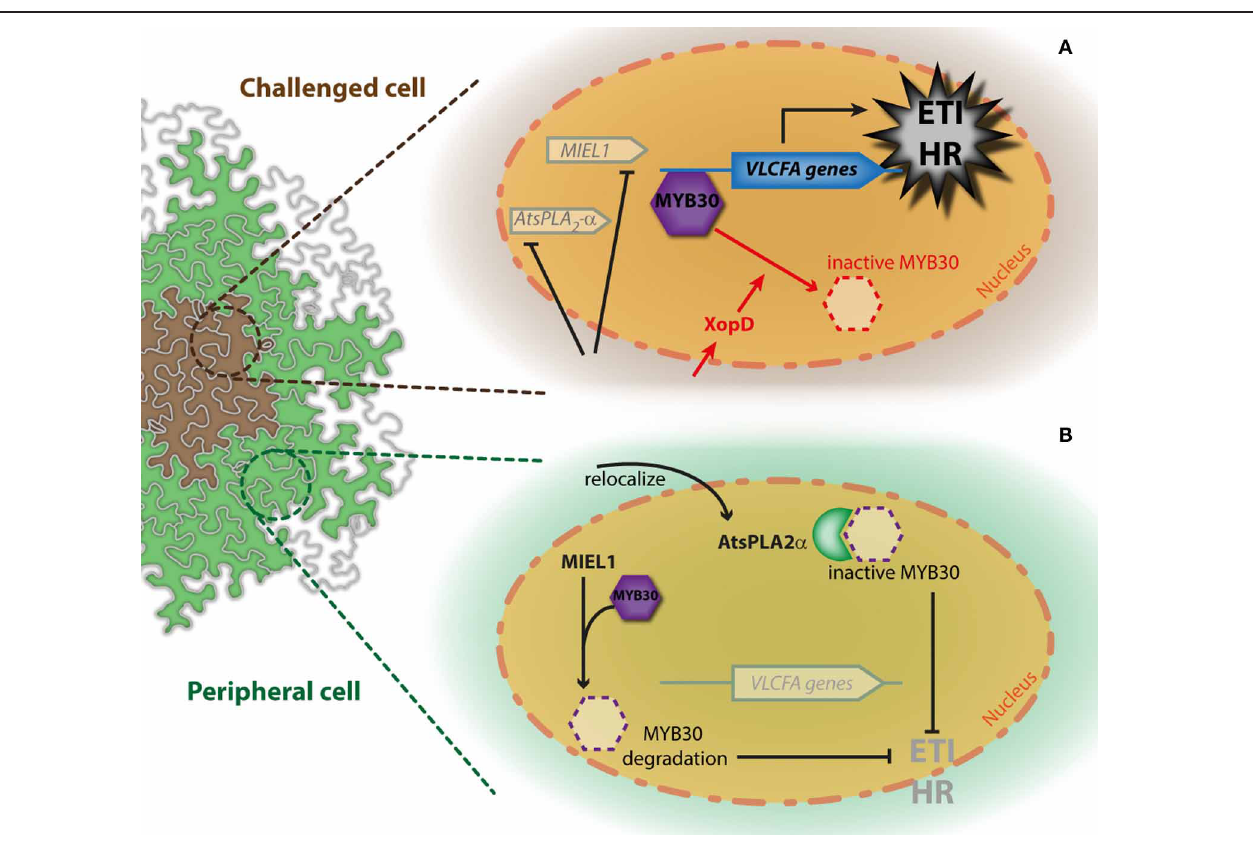
HR development is presented in cells challenged with bacterial inoculation (A) and peripheral cells (B) . Activity of the bacterial XopD effector is shown in red. See the text for